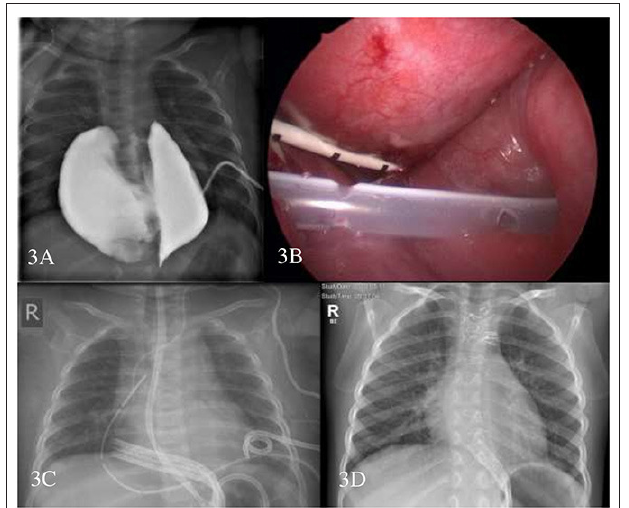
FIGURE 3 | Patient #3. Contrast filling of the intrathoracic central conducting lymphatic anomaly (CCLA) through the pigtail catheter to depict the anatomic relationship (A) thoracoscopic placement of the Denver drain—pigtail drain is seen (B) chest X-ray with multiple drains (C) and chest X-ray 1-year after sternotomy and surgical resection of CCLA (D) .